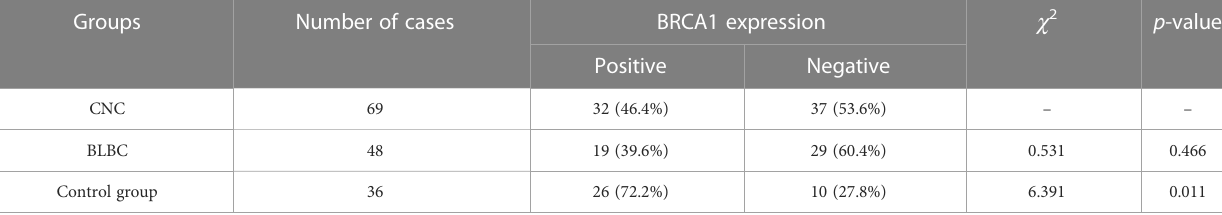
TABLE 3 Comparison of differences in BRCA1 expression between CNC and BLBC and between CNC and control group.